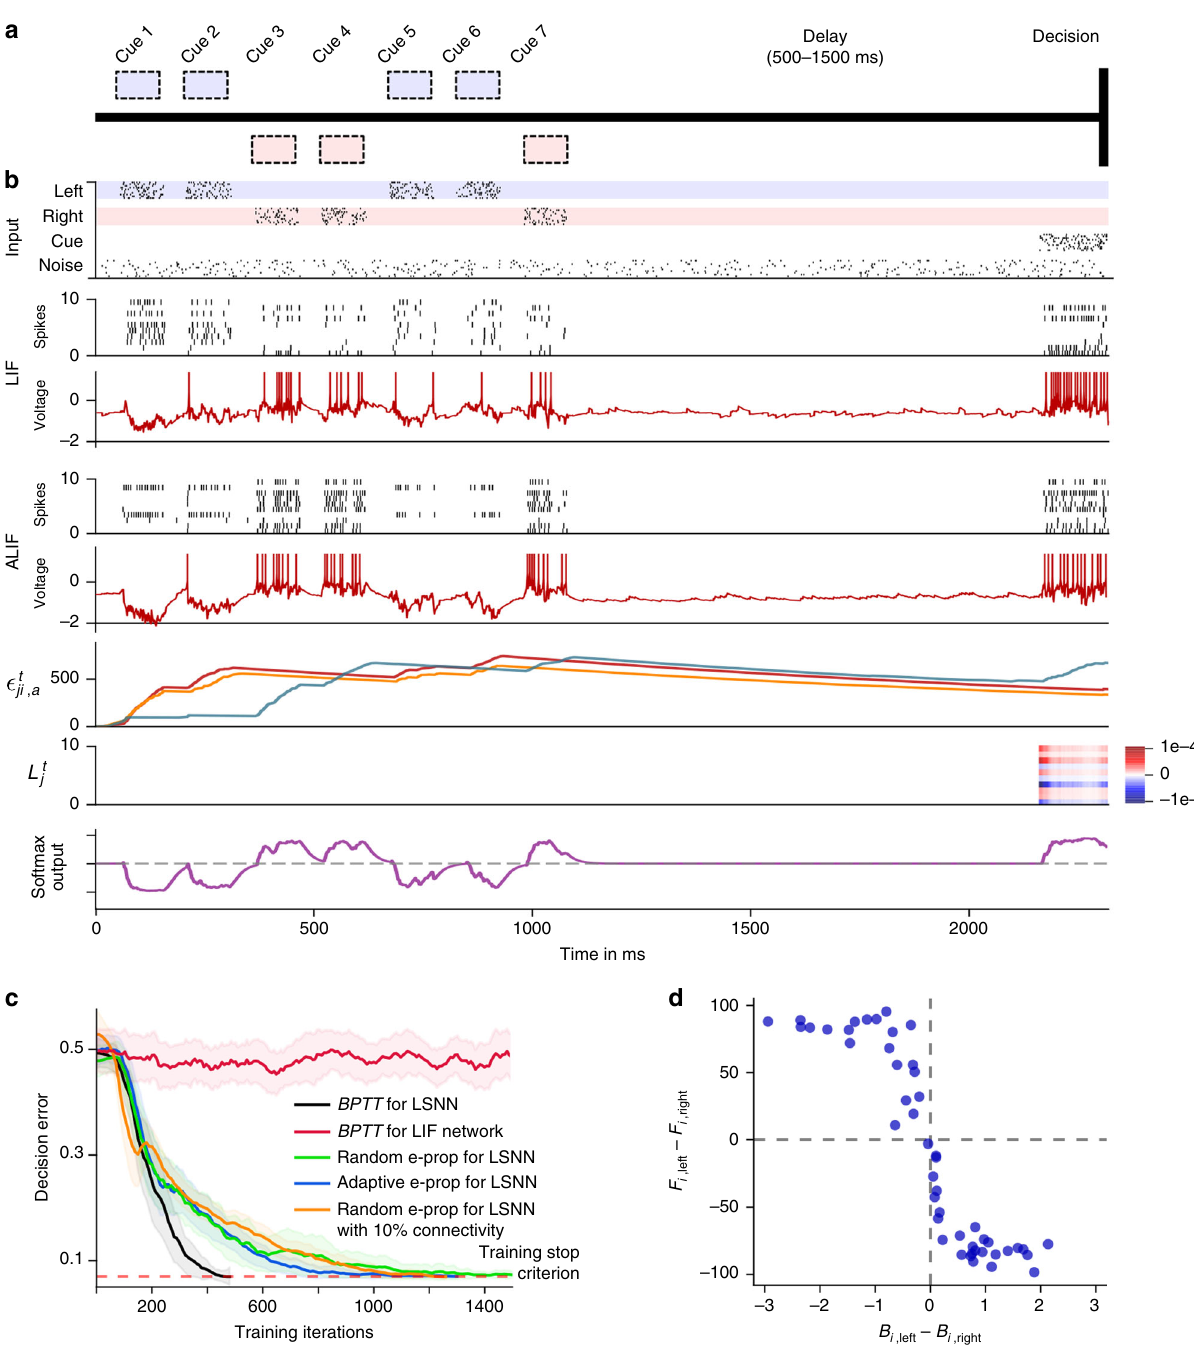
Fig. 3 Solving a task with dif fi cult temporal credit assignment. a Setup of corresponding rodent experiments of ref. 23 and ref. 14 , see Supplmentary Movie 1. b Input spikes, spiking activity of 10 out of 50 sample LIF neurons and 10 out of 50 sample ALIF neurons, membrane potentials (more precisely: v t j (cid:4) A t j ) for two sample neurons j , three samples of slow components of eligibility traces, sample learning signals for 10 neurons and softmax network output. c Learning curves for BPTT and two e-prop versions applied to LSNNs, and BPTT applied to an RSNN without adapting neurons (red curve). Orange curve shows learning performance of e-prop for a sparsely connected LSNN, consisting of excitatory and inhibitory neurons (Dale's law obeyed). The shaded areas are the 95% con fi dence intervals of the mean accuracy computed with 20 runs. d Correlation between the randomly drawn broadcast weights B jk for k = left/right for learning signals in random e-prop and resulting sensitivity to left and right input components after learning. f average fi ring rate of neuron j during presentation of left (right) cues after